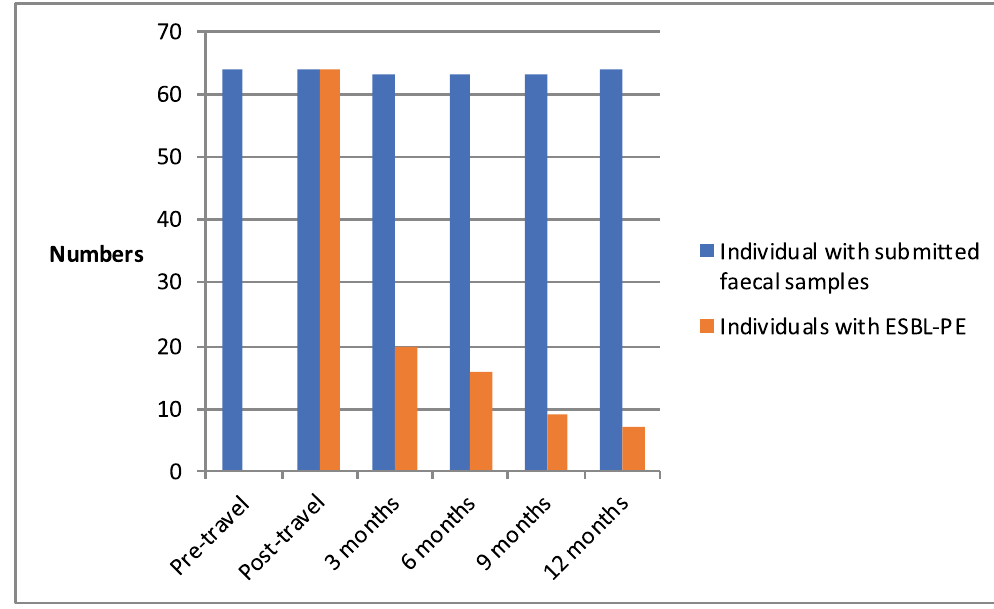
Fig 1. Dynamics of